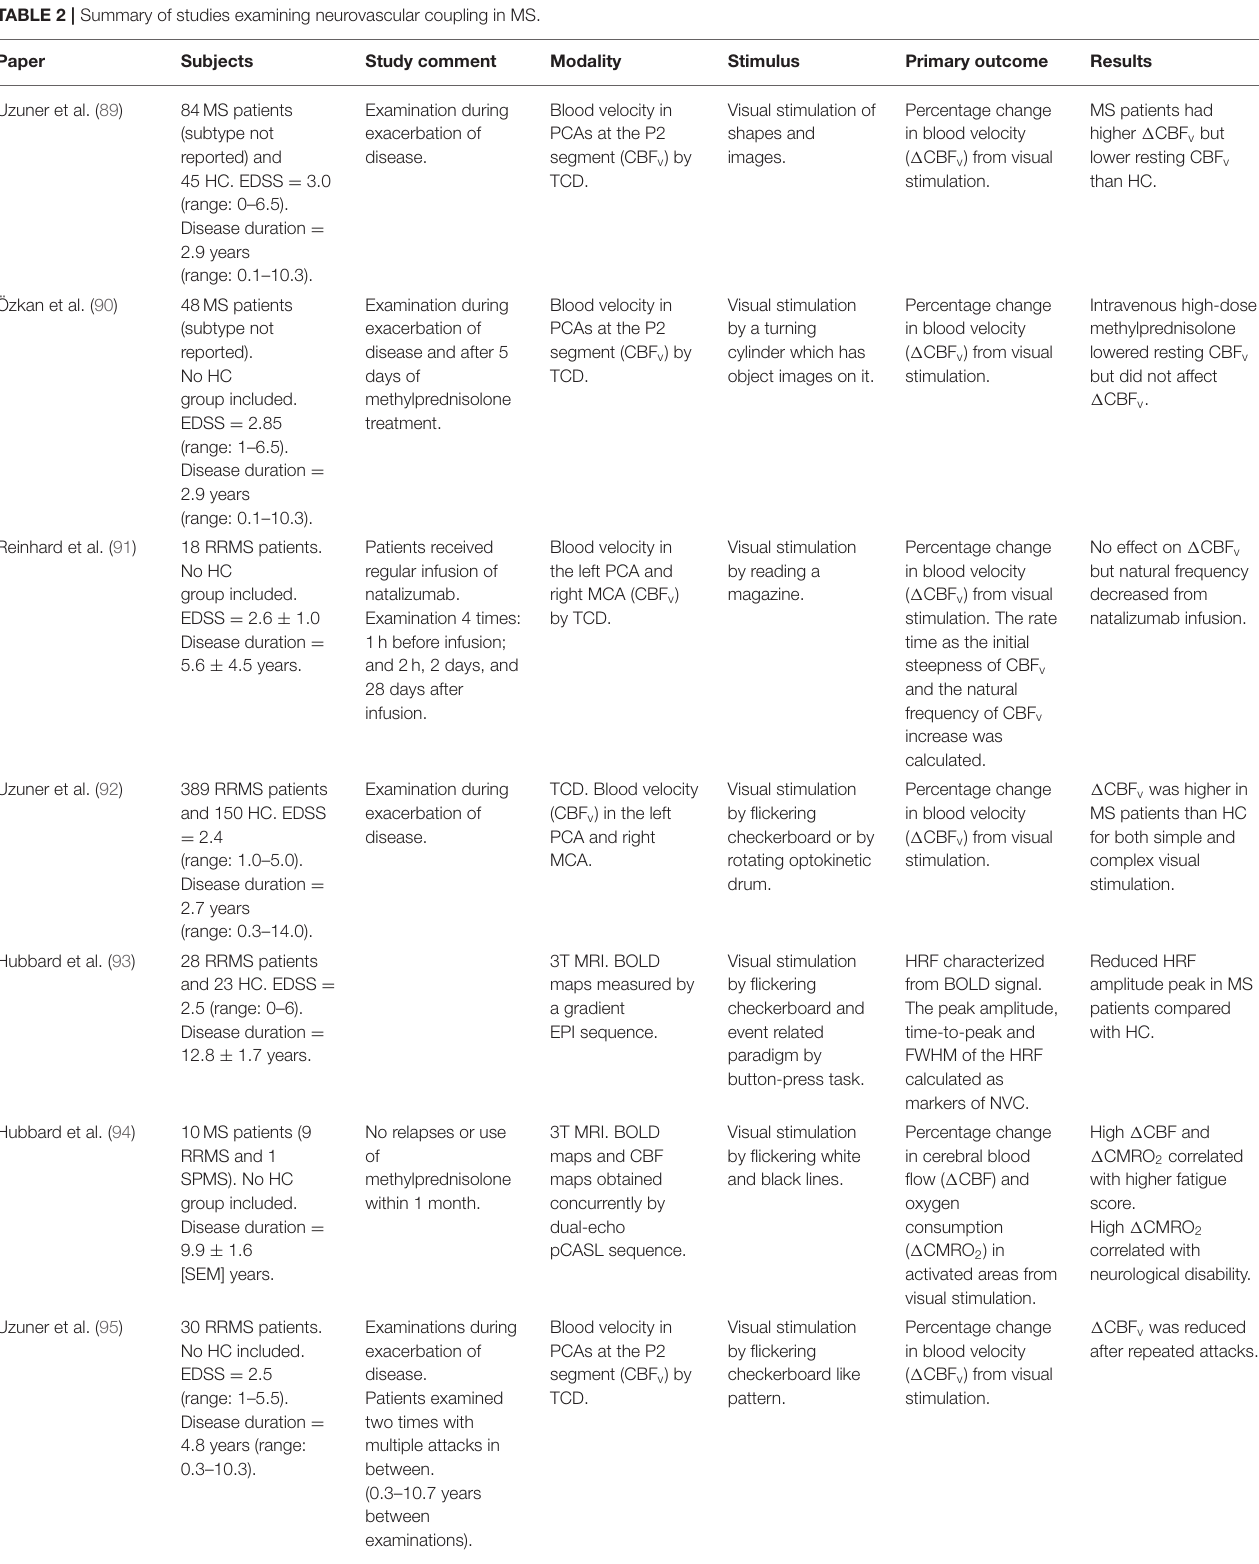
TABLE 2 | Summary of studies examining neurovascular coupling in